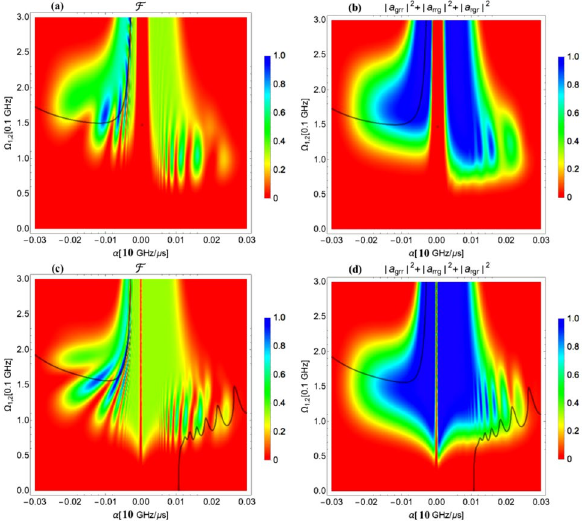
Figure 5. ( a ) The fidelity of the W state as a function of the chirp rate and the peak Rabi frequency for 150 MHz; ( b ) The density plot of the sum of populations of the V 31 V / 2 , V max = = 150 MHz. ( c ) The fidelity of the W state as a function of the chirp rate and the V / 2 , V max states for V 31 = = 120.94 MHz; ( d ) The density plot of the sum of populations of the V / 2 6 , V max peak Rabi frequency for V 31 = = , 120.94 MHz. The parameters used in the calculation are rrg grr rgr V / 2 6 , V max , and the states for V 31 | � | � | � = = 1.4 GHz, and δ 4.5 MHz. The black curves draw the contour where three 1 µ s, (cid:31) 60 THz , τ 0 V = − = − = = contributing states have equal